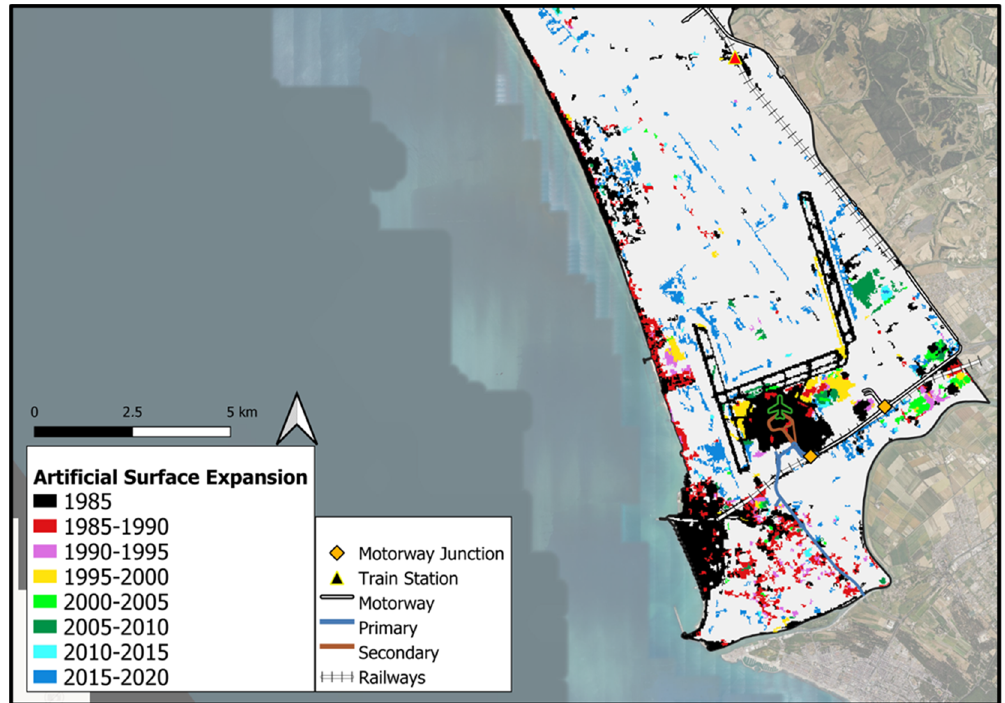
Figure 14. Artificial surface evolution in the municipality of Fiumicino through the 35 years analyzed. Image sieved at a threshold of 10 pixels, 8-bit connectivity.